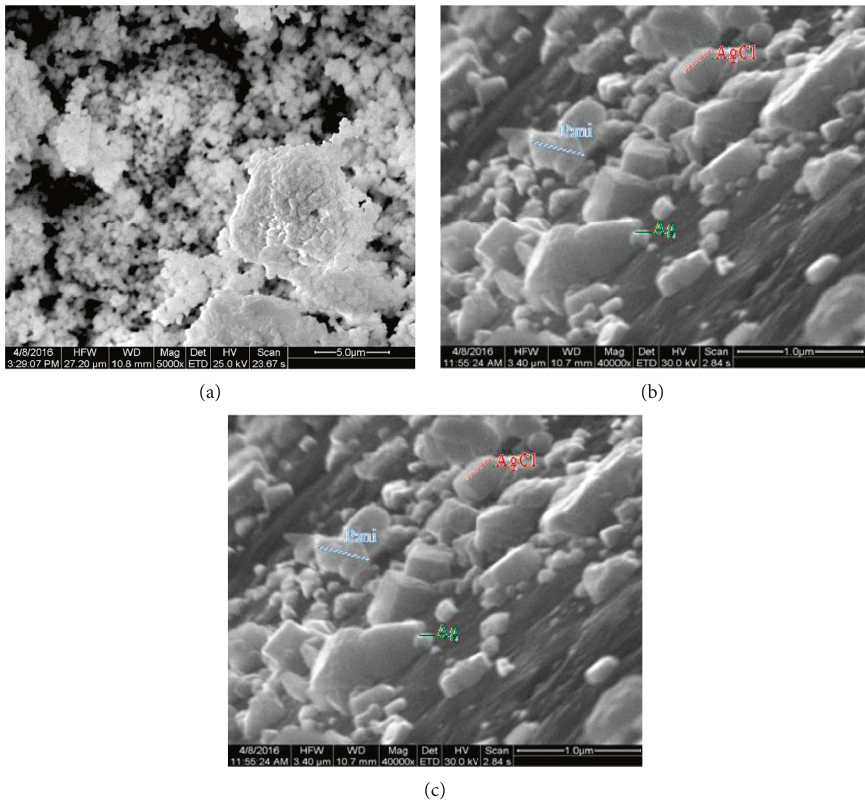
Figure 5: SEM images of the elaborated